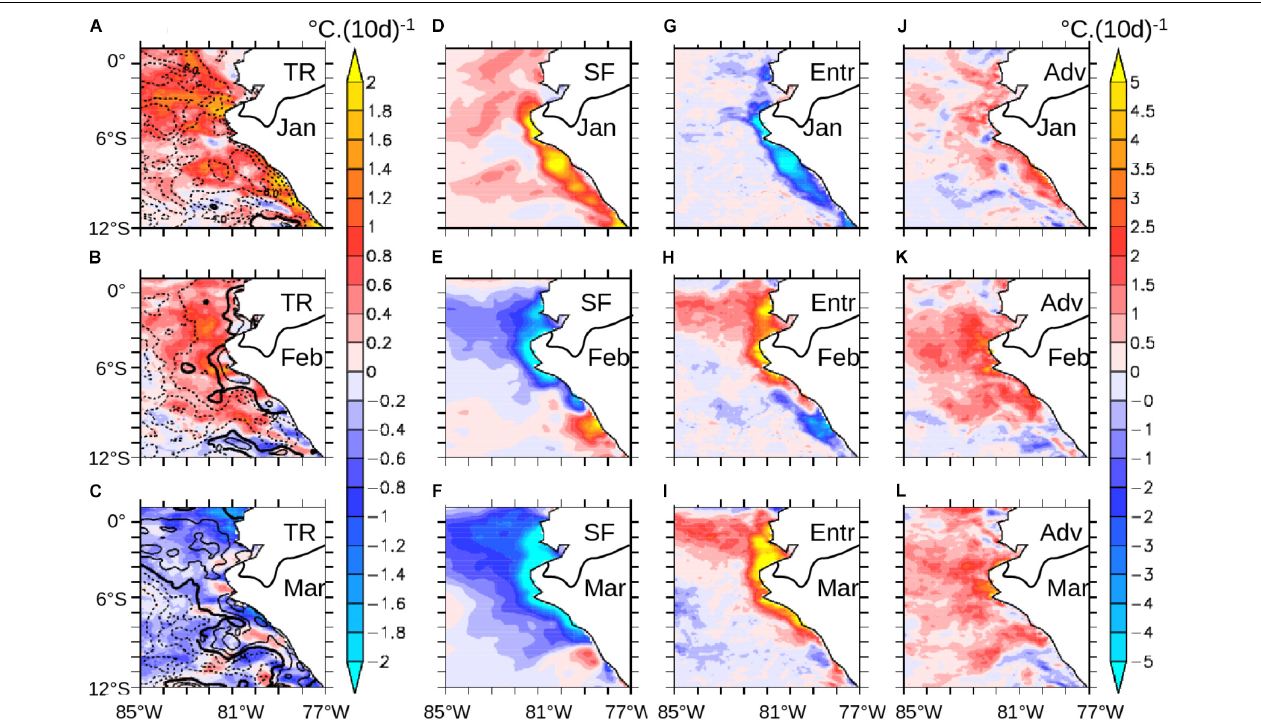
FIGURE 9 | Heat budget in the surface mixed layer. (A–C) Mixed layer temperature rate of change (TR, in ◦ C/10 days, color scale) and mixed layer depth (in meters). The contour interval is 2 m, dashed (full) lines mark negative (positive) values. (D–F) Surface forcing (SF, in ◦ C/10 days). (G–I) Entrainment (Entr, in ◦ C/10 days). (J–L) Advection (horizontal + vertical, Adv, in ◦ C/10 days). Top, middle, and bottom rows correspond to January, February, and March 2017, respectively. Anomalies were computed with respect to the 2013–2016 climatology.